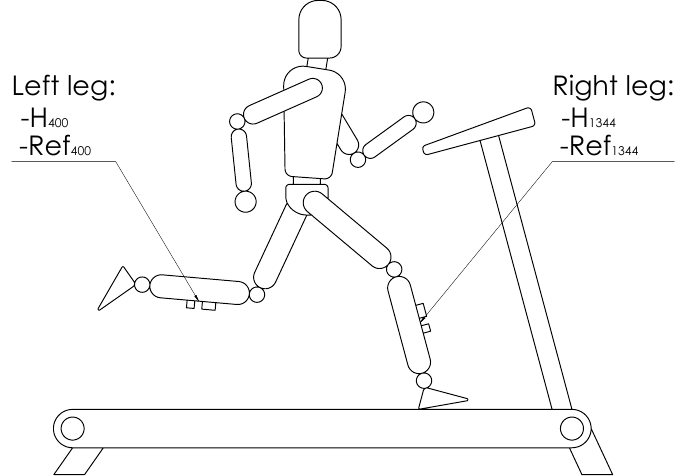
Figure 2. Sensors location on the subject’s legs, with both IMUs (H 1344 , H 400 ) and the associated references (R 1344 , R 400 ).